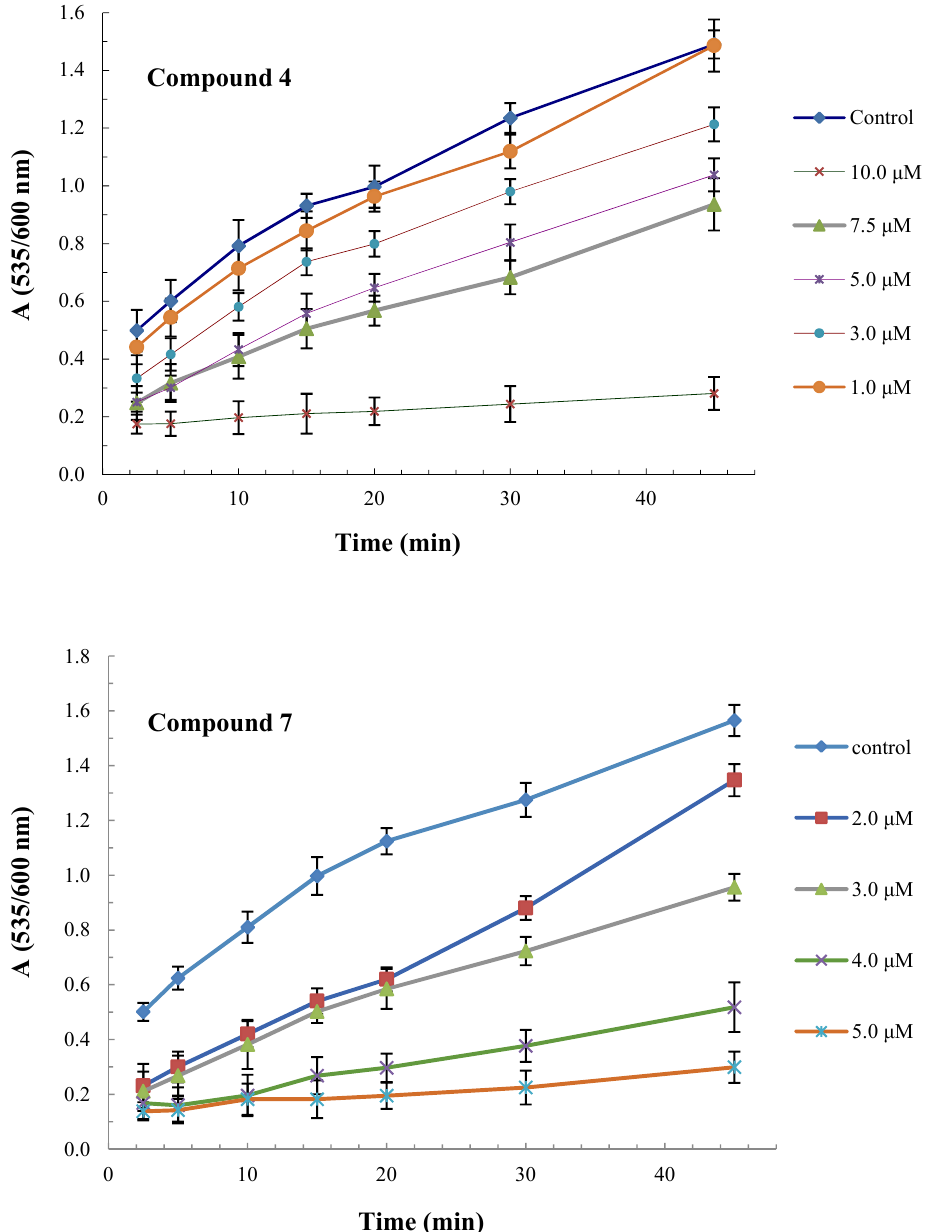
Figure 3. Time course of lipid peroxidation as affected by various concentrations of compounds 4 and 7 .